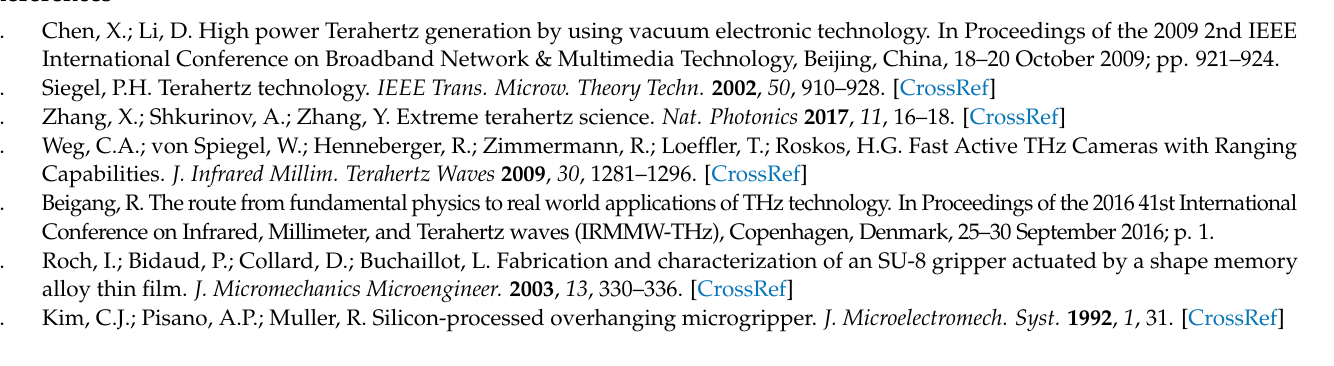
Figure 16. The experimentally measured S 11 and calculated S 11 parameters of the WR2.8 wave ‐ guide.